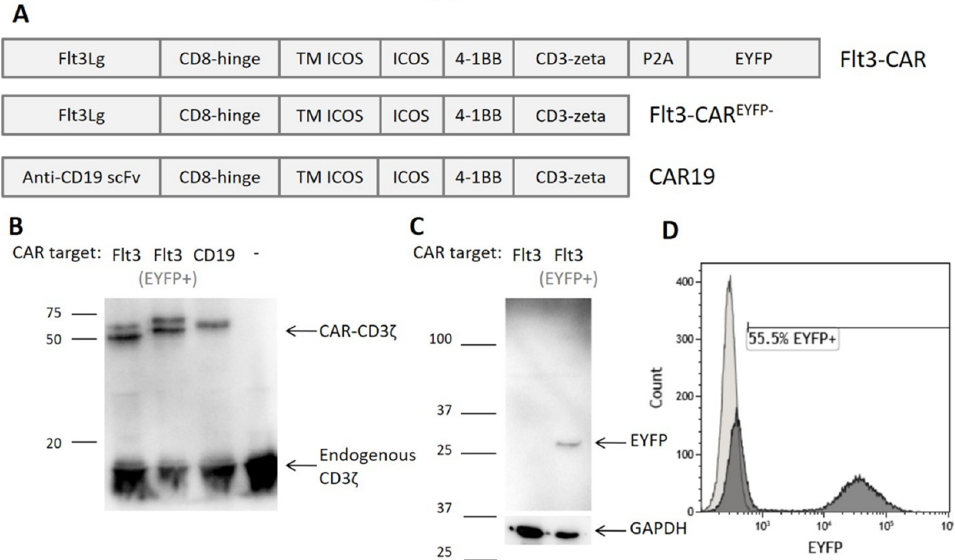
Figure 1. Generation of Flt3-CAR T cells. ( A ) Domain structure of Flt3-CAR, Flt3-CAR EYFP- , and CAR19 coding regions (EYFP stands for enhanced yellow fluorescent protein). ( B ) Western blot demonstrating synthesis of chimeric receptor proteins in transduced cells. High bands corresponding to CD3 ζ domain of the chimeric receptors (50–60 kDa) are observed in all lanes except negative control (non-transduced T cells). Lower bands corresponding to the CD3 ζ part of the endogenous T cell receptor complex (16 kDa) are present in all lanes. ( C ) Western blot demonstrating synthesis and proper cleavage of EYFP protein in Flt3-CAR T cells. The arrow indicates a single band of appropriate size for EYFP (27 kDa). ( D ) A representative flow cytometry histogram showing EYFP synthesis in Flt3-CAR T cells on day 7 after transduction.